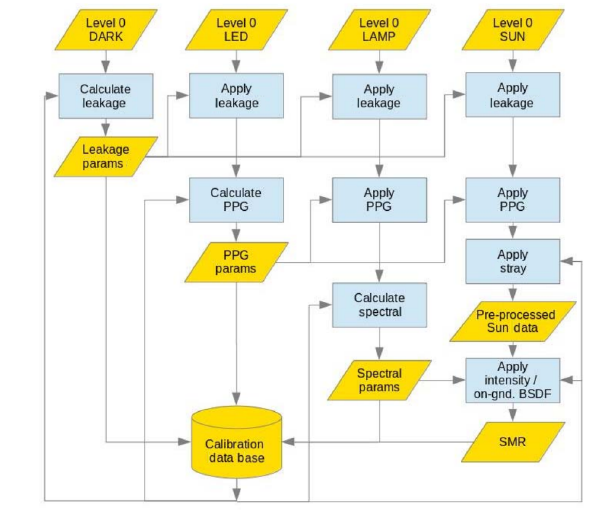
Figure 3. Processing flow indicating the order of steps for calcu- lating the calibrated level 1 science data, i.e., irradiance (left col- umn), moon radiance (middle column), and earthshine radiance (right columns). See text for detailed